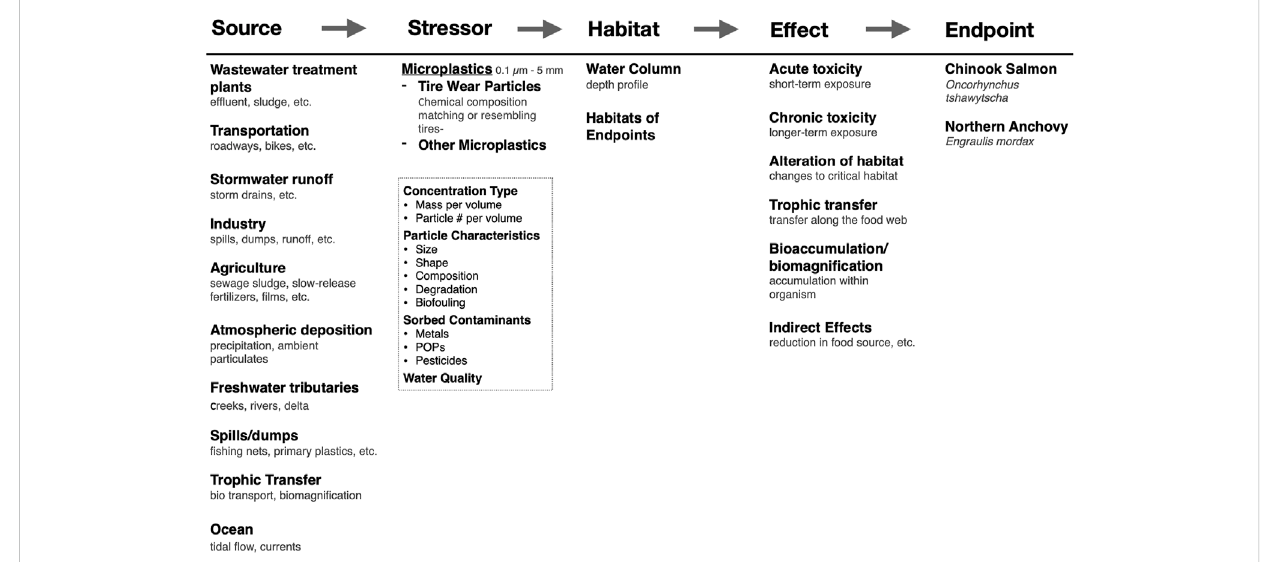
FIGURE 4 A conceptual model for an ecological risk assessment framework for microplastics and nanoplastics for the San Francisco Bay estuary. The cause- effect framework is at the top and fi ts the source-stressor-habitat/location-effect-endpoint/impact